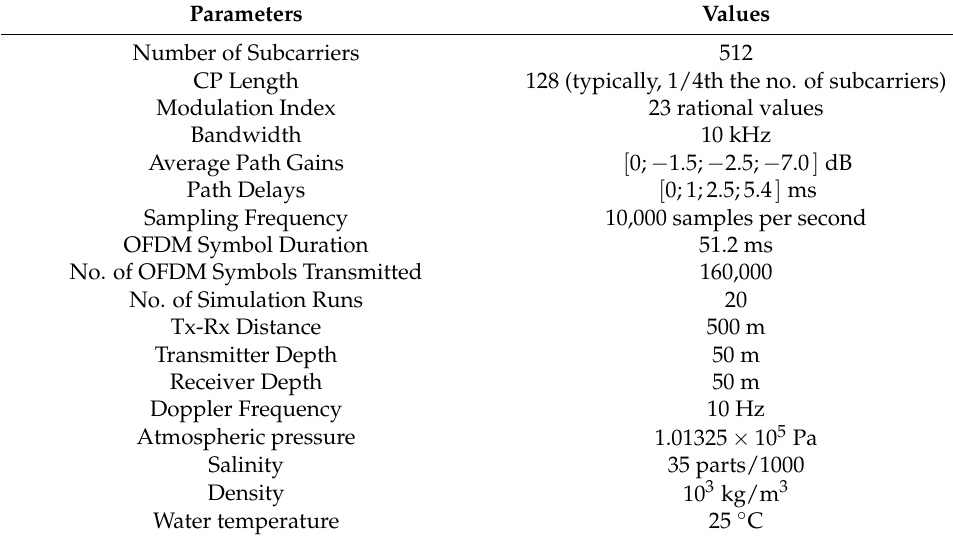
Table 1. Simulation